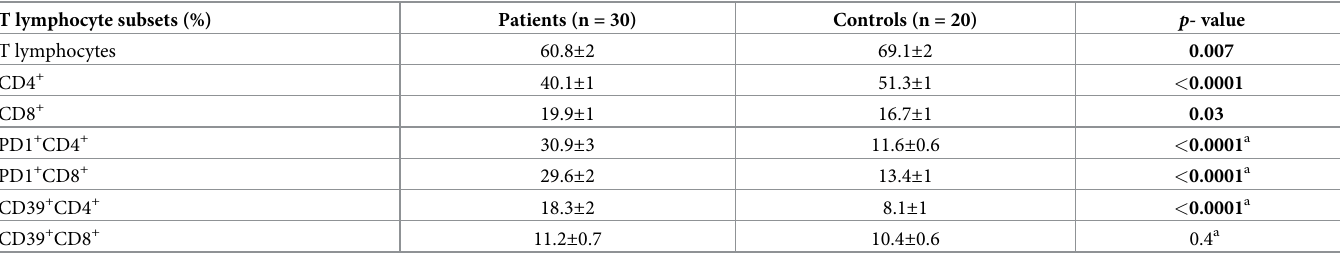
Correlations between different peripheral and tissue T lymphocyte subsets are demonstrated in Table 5. Peripheral PD1 + CD4 + T lymphocytes showed positive correlations with both tissue Table 3. Differential expression of PD1 and CD39 on peripheral blood T lymphocytes among patients with triple-negative breast cancer and controls. T lymphocyte subsets